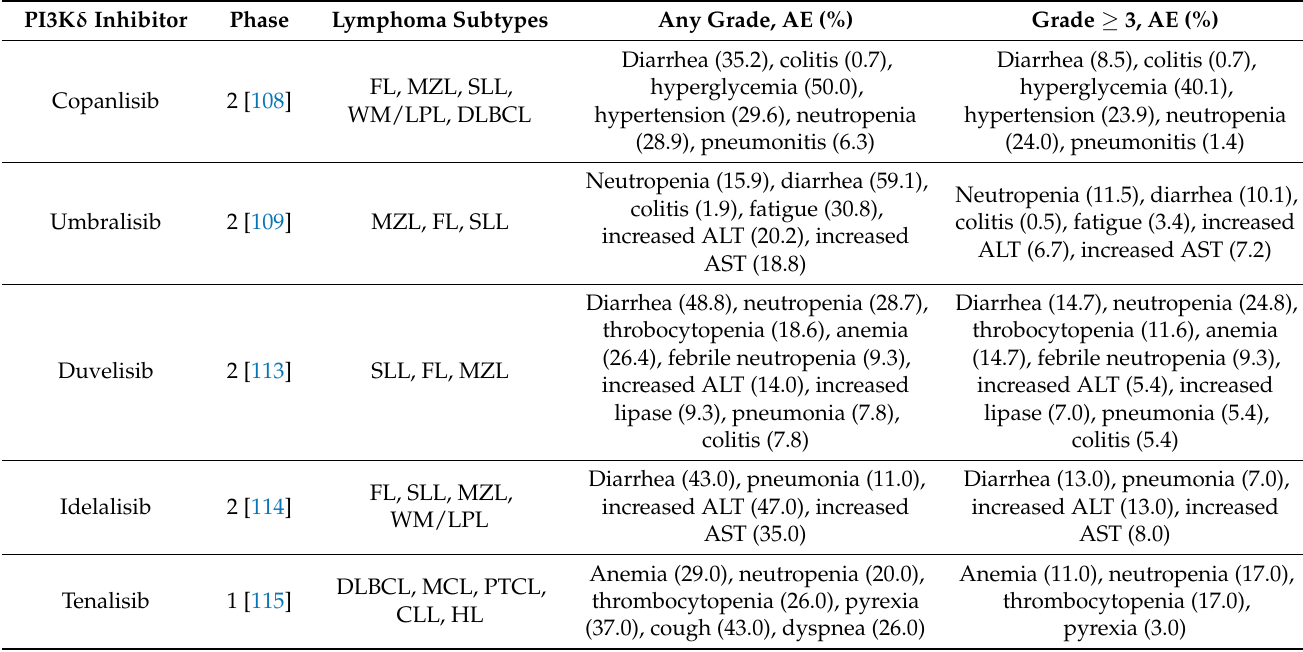
Table 3. Potential toxicities of the PI3K δ inhibitors in the context of clinical trials enrolling patients with lymphoma. PI3K δ